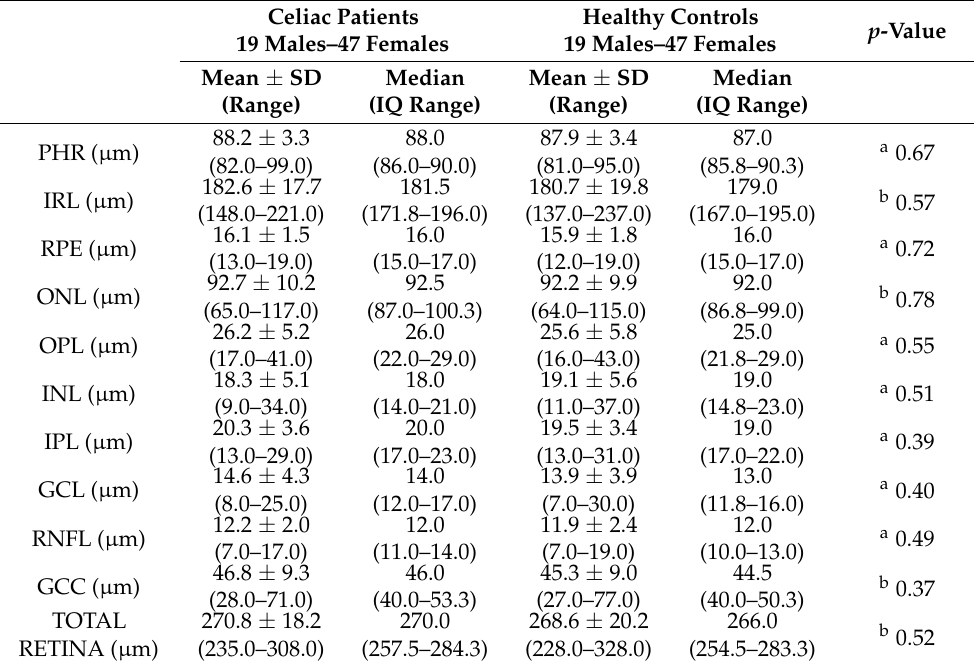
Table 1. Comparison of average retinal layer thicknesses ( µ m) between celiac patients and healthy subjects at 1 mm diameter of ETDRS grid on OCT.